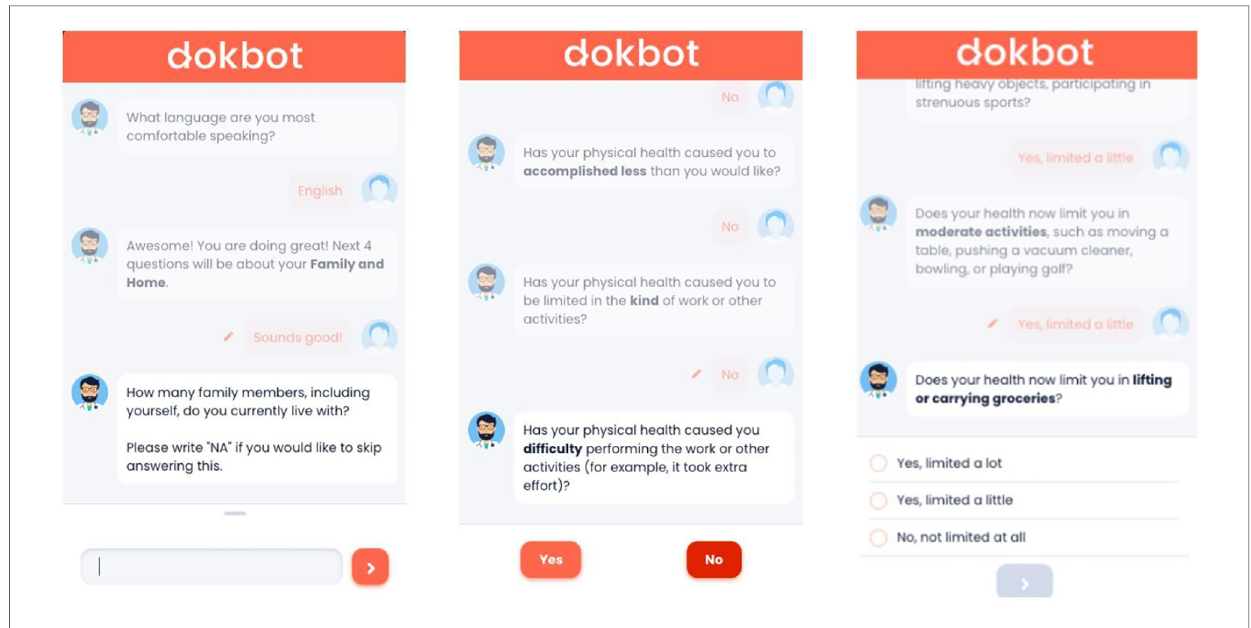
FIGURE 1 Chatbot interface showing various questions and response types.